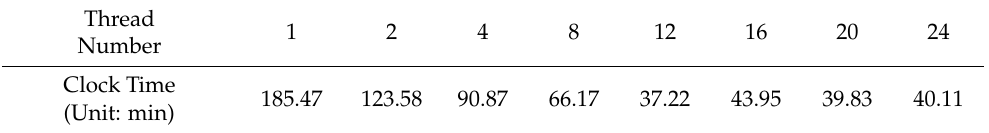
Table 6. Clock time with the corresponding usage of the thread number in the workstation. It is noted here that 1 CPU has 2